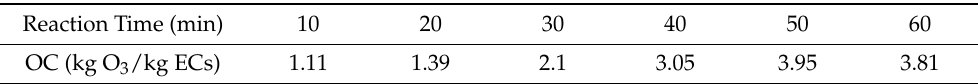
Table 4. Consumption of ozone at reaction